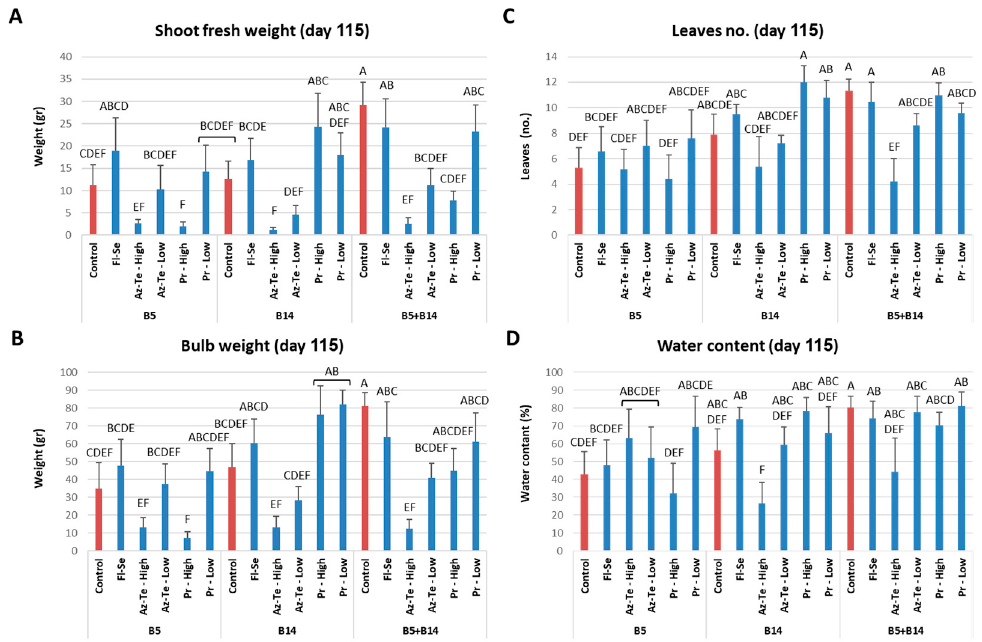
Figure 7. Effect of pesticide treatments on onion weight of white onion plants (Orlando cv.) 115 days after germination. The experiment and abbreviations are described in Figure 2. The harvest evaluation included the plants’ shoot fresh weight ( A ), bulbs’ wet weight ( B ), phenological development (number of leaves, C ), and water content ( D ). B5- F. acutatum , B14- F. oxysporum f. sp. cepae . Bars indicate the mean of five (Prochloraz and Az-Te) or 10 (Fl-Se) biological replications (pots). Controls (red columns) are plants without fungicides. Error bars are standard errors. Different letters above the chart’s bars (A–F) represent a significant difference ( p < 0.05) in the ANOVA test.